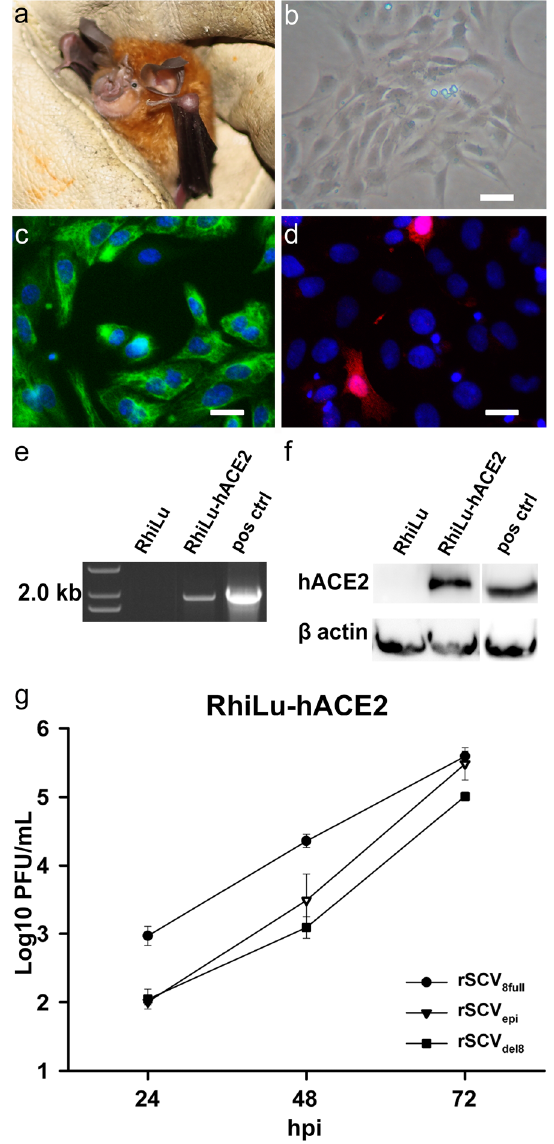
Figure 3. Generation of an hACE2-transgenic bat cell line for infection experiments with ORF8 variant rSCV. ( a ) Picture of an African Rhinolophus alcyone bat (copyright Victor Max Corman). Primary cell culture and immortalization of R. alcyone embryonic lung cells ( b ) was done as described in the Material and Methods section. To determine the RhiLu cell type the epithelial protein marker cytokeratin ( c ) and the fibroblast marker S-100A4 ( d ) were detected by immunofluorescence assay using mouse-anti cytokeratin or rabbit-anti S-100A4 Ig. Secondary detection was performed by incubating with goat-anti-mouse cyanin 2- or goat-anti-rabbit cyanin 3-labeled Igs. The bars represent 20 µ m. ( e ) Integration of hACE2 into the genome of RhiLu cells was verified by PCR. The vector containing the hACE2 -puromycin resistance gene construct was used as a PCR positive control. ( f ) Expression of hACE2 was confirmed by Western blot analysis using mouse anti-hACE2 Ig (1:1,000). In addition, β actin protein was detected using rabbit anti- β -actin Ig (1:2,000) to ensure that similar protein amounts were applied. MA104 cells, expressing hACE2 naturally, served as positive control. ( g ) Virus replication of rSCV 8full , rSCV epi and rSCV del8 was observed by titration of supernatants sampled at 24, 48, and 72 hpi. Cells were infected in triplicates at an MOI of 0.001. Error bars represent standard deviation of the